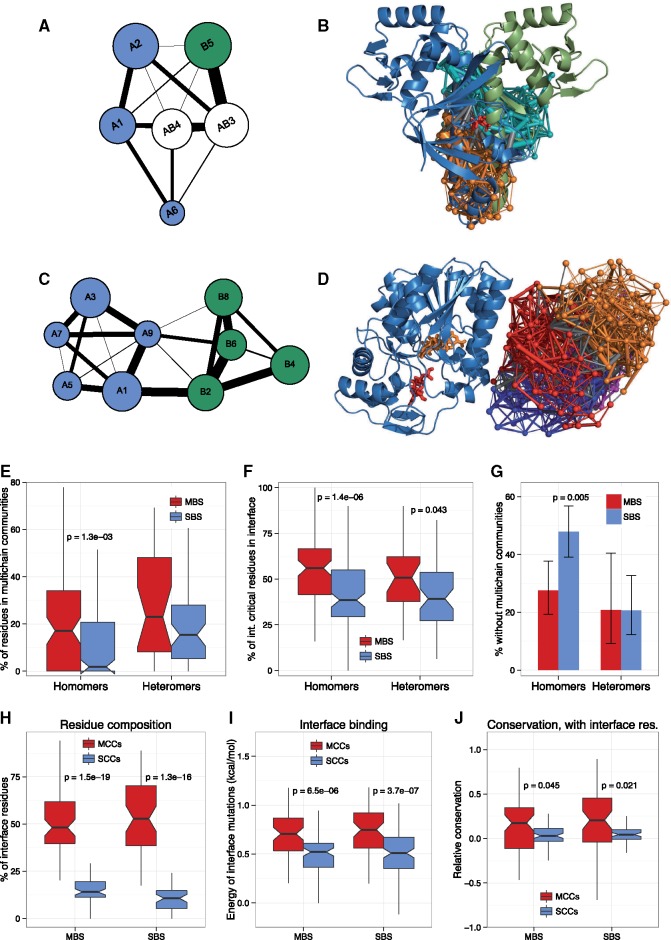
The allosteric pathways of MBS and SBS complexes are different. (A) Community structure of NtcA dimer. Two of its six communities, indicated with white, are MCCs, containing residues from both protein chains. (B) Localization of the NtcA MCCs in the homodimer (PDB ID: 3la3). (C) Community structure of UDP-galactose 4 epimerase. None of its nine communities are MCCs. (D) Visualization of the communities on chain B of the dimer (PDB ID: 5gy7). (E) In homomers, the percent of residues in MCCs is significantly higher than in heteromers. (F) The fraction of critical residues in protein–protein interfaces is significantly higher in MBS complexes than in SBS complexes, both in the case of homomers and heteromers. (G) In homomers, the fraction of complexes without MCCs is significantly lower in ones with MBSs. (H) In both MBS and SBS homomers, the fraction of interface residues in MCCs is significantly higher than in SCCs. (I) In MCCs, mutating individual interface residues to alanine results in significantly larger changes in the binding energy of interfaces than in SCCs, irrespectively of the type of the homomer. Note that only residues that are part of an interface were used, both in MCCs and SCCs. This indicates that in MCCs, the interactions of interface residues are much stronger than between interface residues of SCCs. (J) Conservation of residues in MCCs is significantly higher than in SCCs, although this is mostly due to their higher fraction of interface residues. (Tests of proportions on panel G, Wilcoxon tests on all other panels. Note that on all panels, P values are provided only for significant differences.)